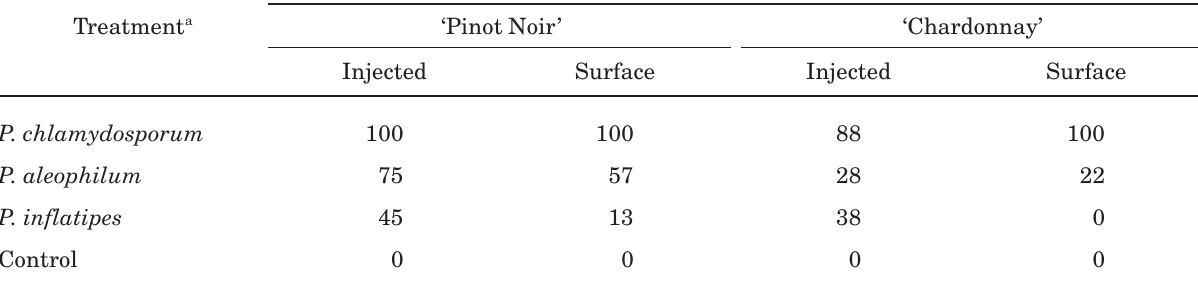
Table 4. Black discoloration in vascular tissue of spurs of standing grapevine in cv. Pinot Noir and Chardonnay inoculated with Phaeoacremonium chlamydosporum, P. aleophilum and P. inflatipes . Pathogens were either inject- ed into the pith or applied as a drop of spore suspension (10 6 conidia ml -1 ) to the cut surface of grapevine spurs. No. of spurs with black vascular streaking (%) a